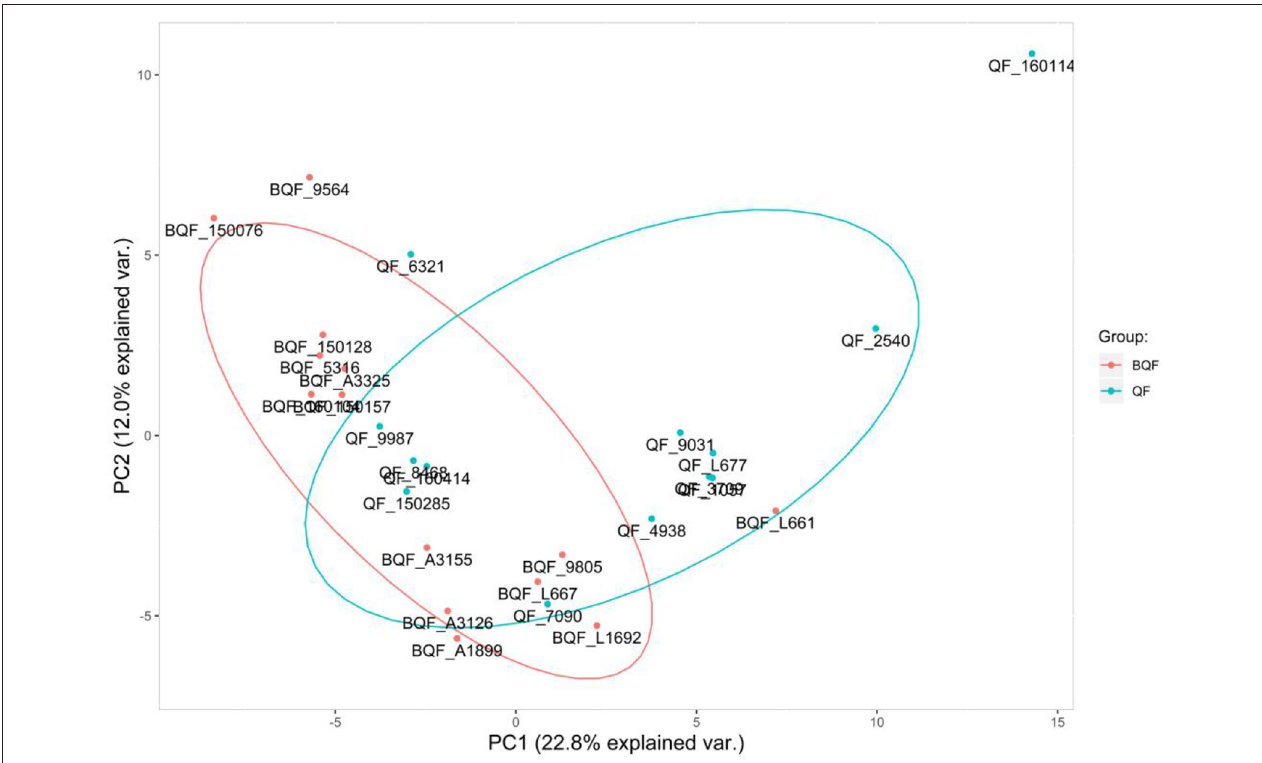
FIGURE 2 | Principal component analysis. The abscissa is the PC1 result, and the ordinate is the PC2 result. Red represents the healthy controls (BQF group), and blue represents the subclinical VE deficiency cows (QF group). It can be seen that there is a certain separation trend between the two groups of samples.